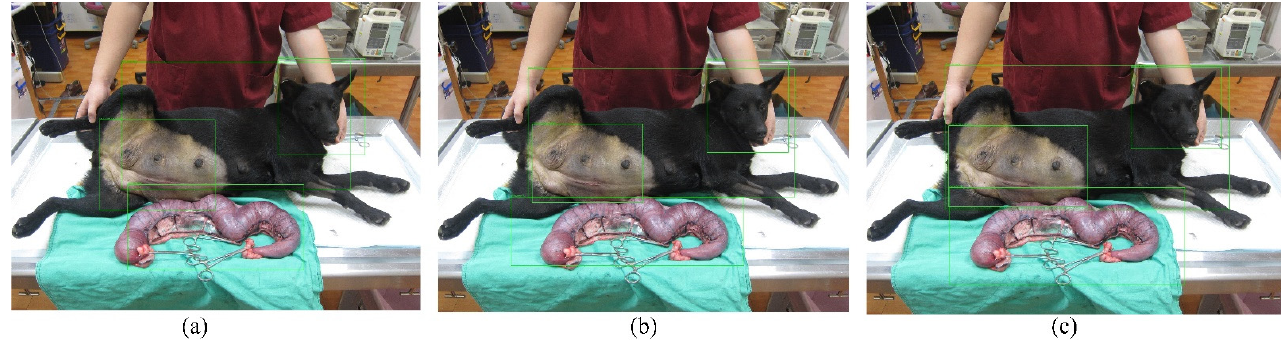
Table 3. Detection performance for female dog.